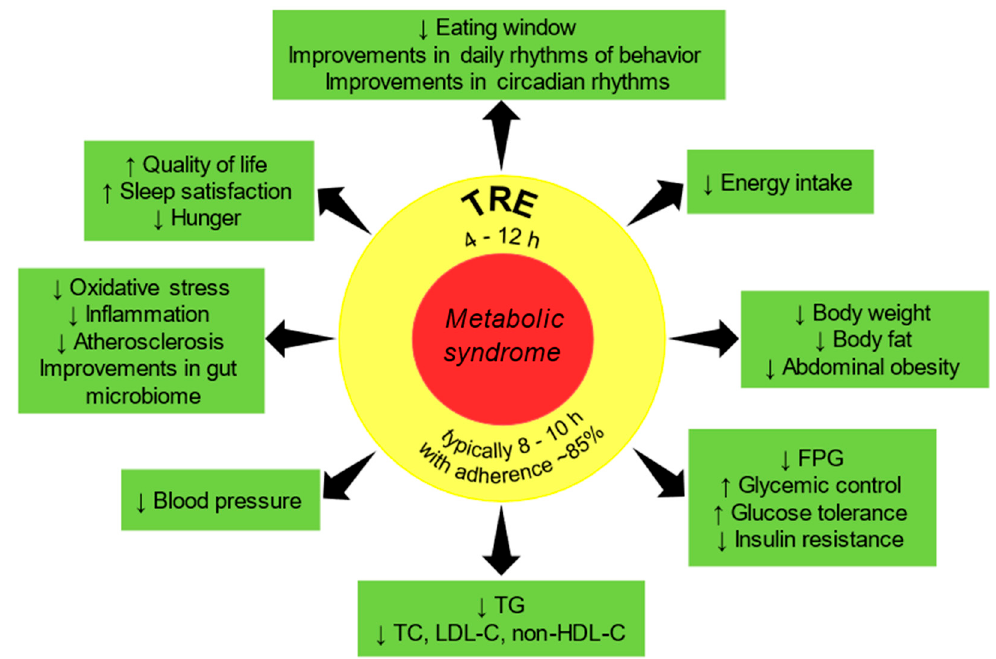
Figure 1. Demonstrated and potential cardiometabolic benefits of time-restricted eating (TRE). FPG: fasting plasma glucose; LDL-C: low-density lipoprotein cholesterol; non-HDL-C: non-high-density lipoprotein cholesterol; TC: total cholesterol: TG: triglycerides. The arrow pointing down indicates a decrease and the arrow pointing up indicates an increase.